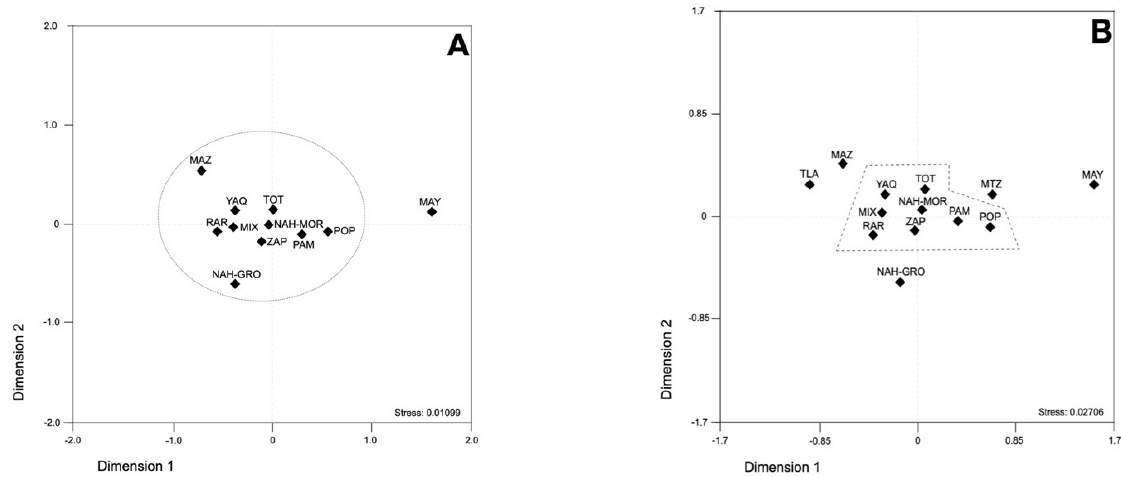
Figure 2. Multidimensional scale plot of RST values using five SCA microsatellite loci data, and the ethnicity criterion for contemporary Mexican Native Americans ( A ) and contemporary Mexican Native Americans and the Mexican Mestizos from the Central Valley of Mexico and Tlaltetela Veracruz ( B ). Mayans-MAY; Mazahuas-MAZ; Mixes-MIX; Nahuas-Guerrero-NAH-GRO; Nahuas-Morelos-NAH-MOR; Pames-PAM; Popolucas-POP; Rarámuris (Tarahumaras)-RAR; Yoemem (Yaquis)-YOE; Mexican Mestizos from the Central Valley of Mexico—CMV; Mexican Mestizos from Tlaltetela, Veracruz-TLA. Dotted lines enclose those populations that show genetic connections between them (no significant genetic distances); p -values were adjusted with the method of false discovery rates in R-software.